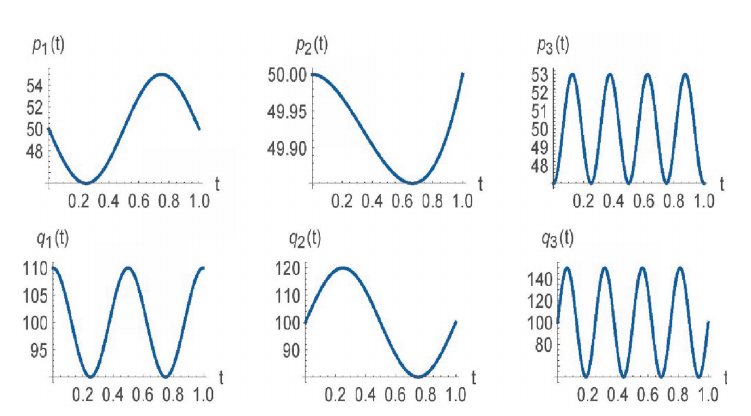
Figure 1. Comparison of price and quantity processes for three considered